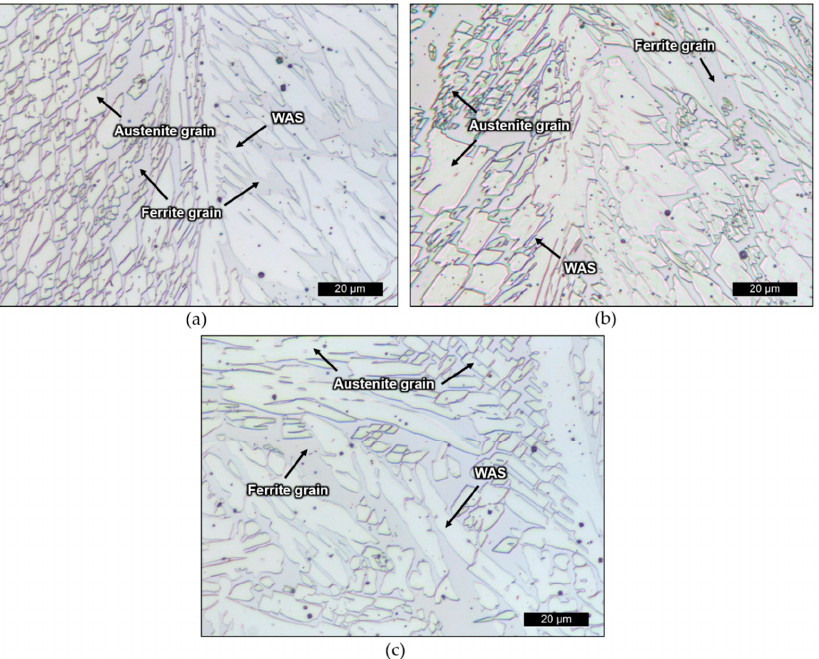
Figure 13. Microstructure in top layer in; ( a ) Sample No. 1 (0.40 kJ/mm), ( b ) Sample No. 2 (0.54 kJ/mm) and ( c ) Sample No. 3 (0.87 kJ/mm). WAS—Widmanstätten austenite side-plate. Metals 2020 , 10 , 272